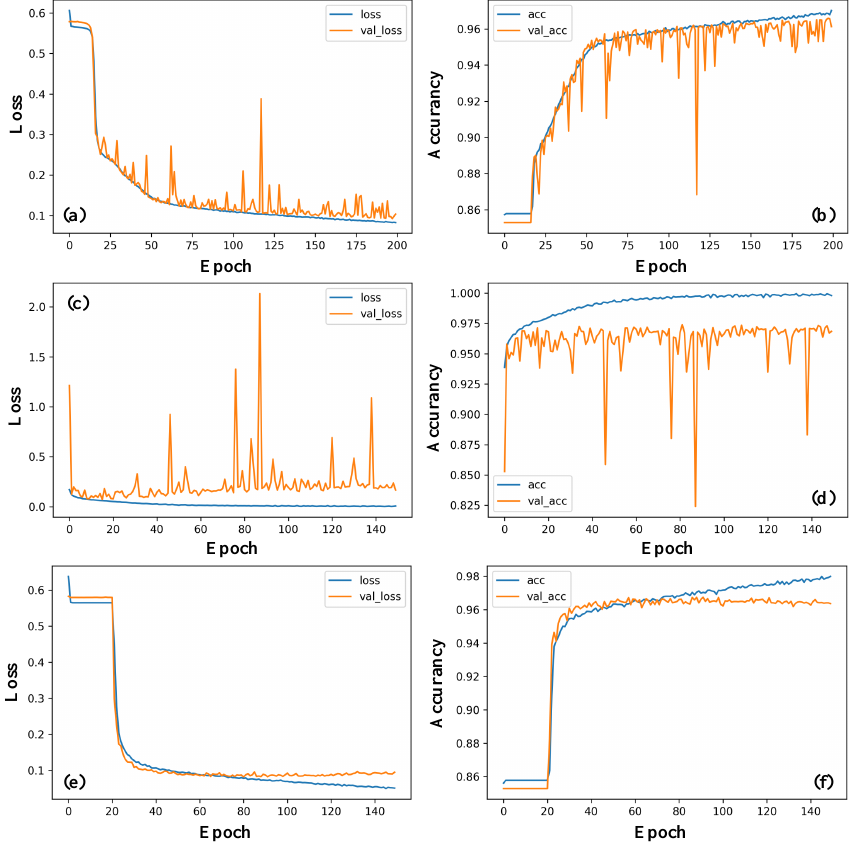
Figure 7. Training loss and accuracy curve of ( a , b ) 1D-CSNN, ( c , d ) 1D-CNN, and ( e , f ) LSTM based on time-domain